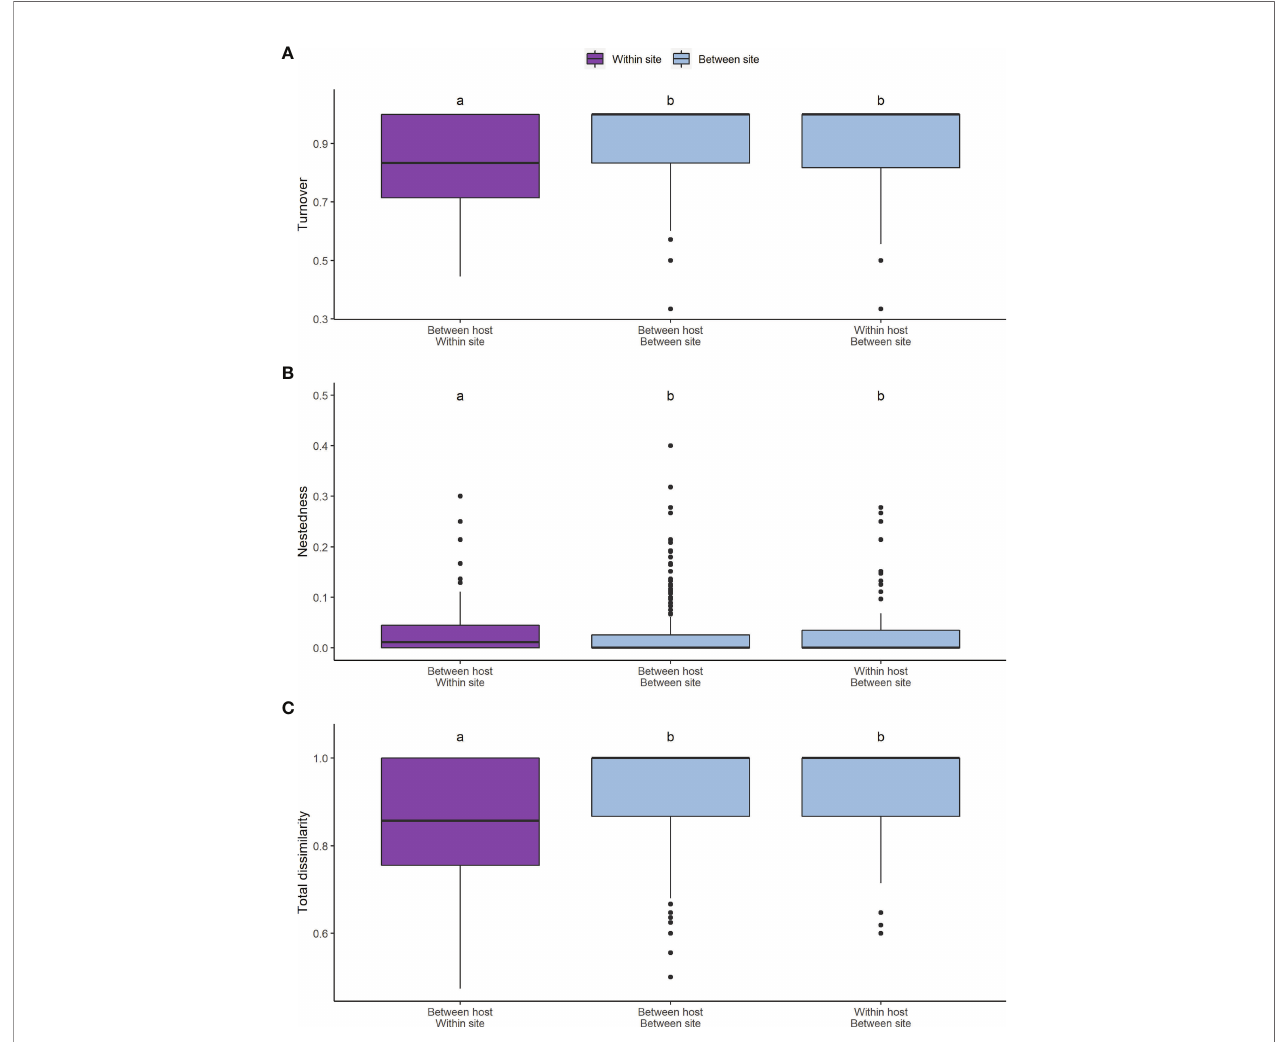
FIGURE 5 | Pairwise Sorensen ’ s index for betadiversity across sites and ericaceous hosts. In addition to (C) the total pairwise dissimilarity (p<<0.001), the (A) turnover (p<<0.001) and (B) nestedness (p=0.011) components of betadiversity are shown. Signi fi cantly different groupings identi fi ed by a Dunn test are indicated by letters over the